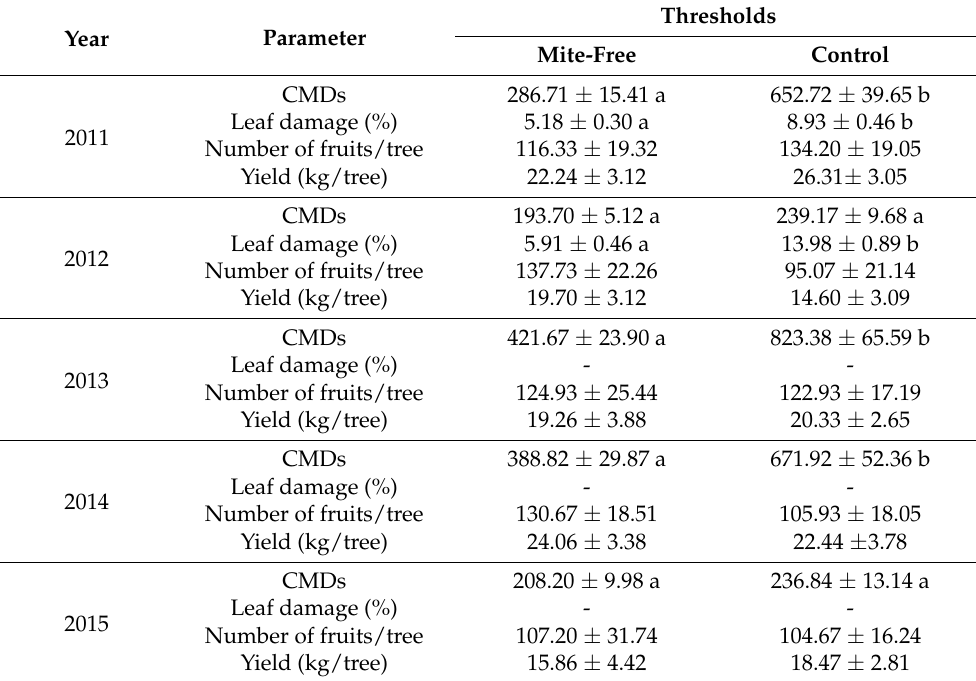
Table 5. Mean ( ± SE) CMDs, leaf area damage (%), number of fruits per tree, and yield (kg) for avocado trees subjected to two treatments in M á laga. Different letters mean significant differences (Tukey’s HSD multiple range test, p <